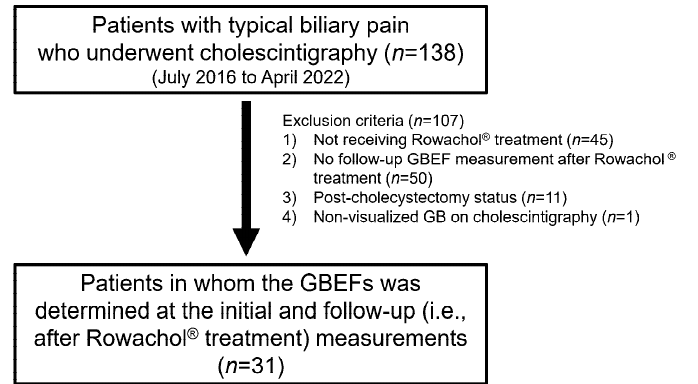
Figure 1. Flow chart for the study population. GBEF, gallbladder ejection fraction; GB, gallbladder.